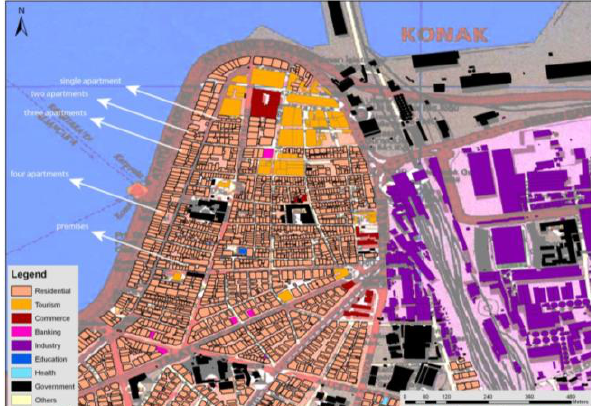
Figure 3. Part of the vector map showing the residential areas and building footprints